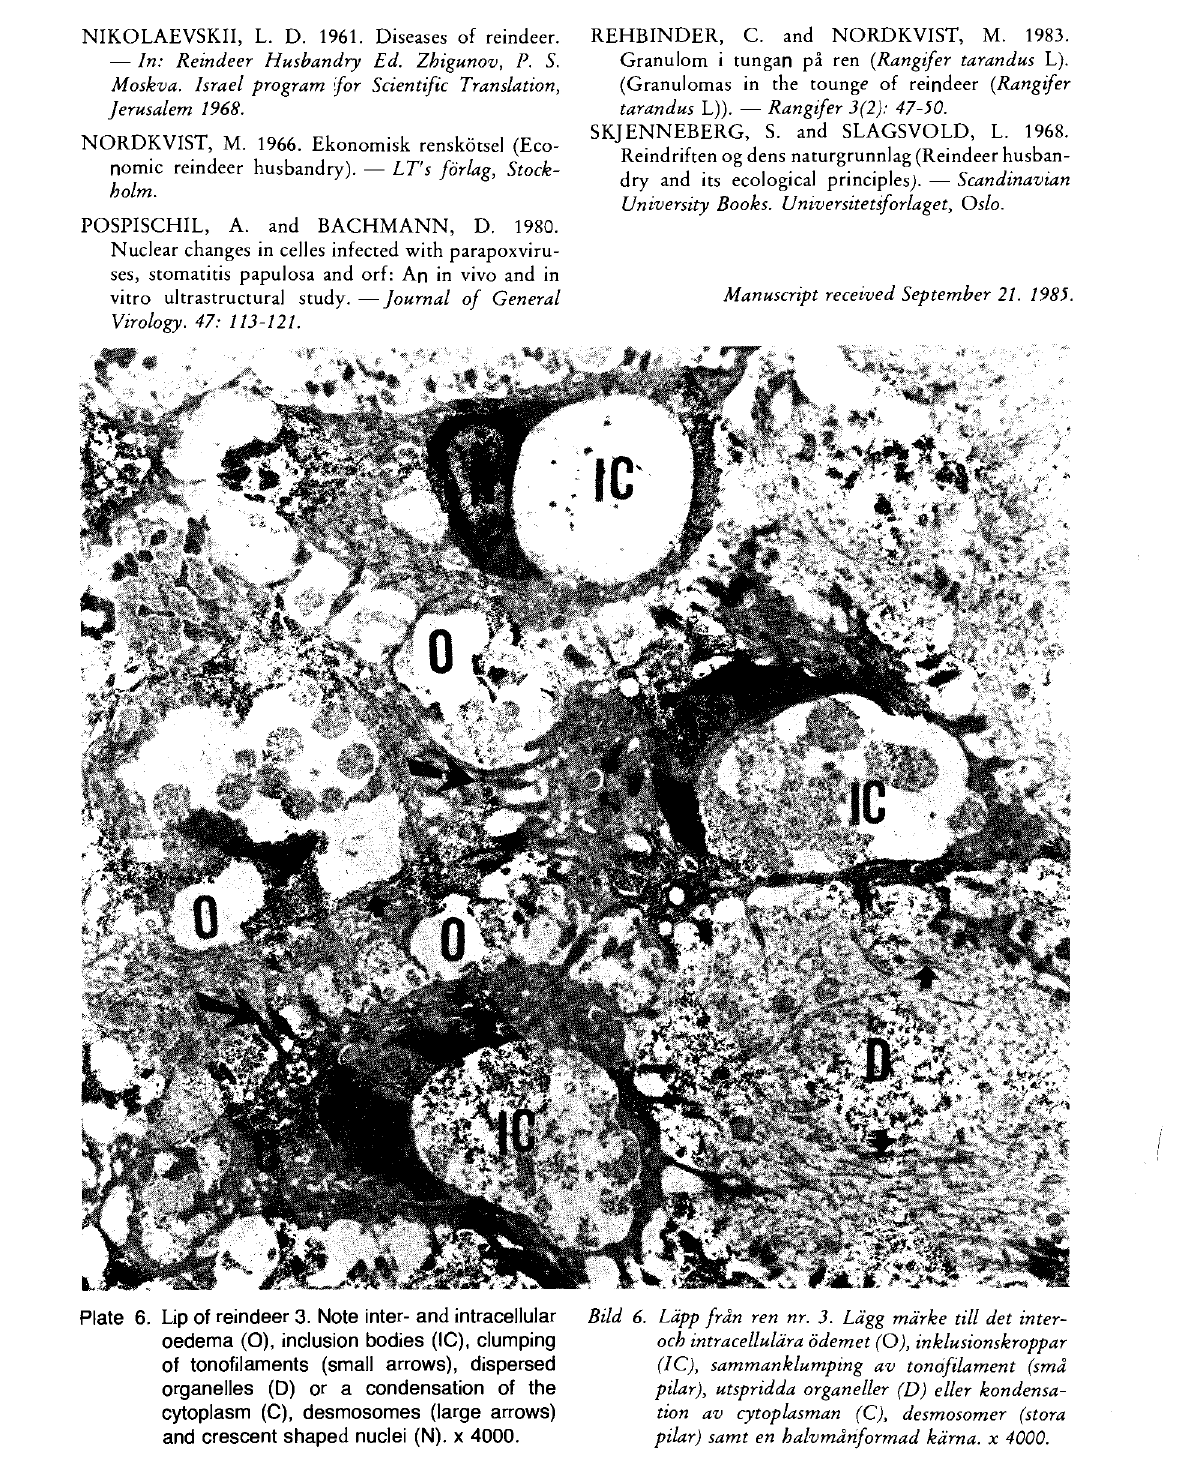
Lip of reindeer 3. Note inter- and intracellular oedema (O), inclusion bodies (IC), clumping of tonofilaments (small arrows), dispersed organelles (D) or a condensation of the cytoplasm (C), desmosomes (large arrows) and crescent shaped nuclei (N). x